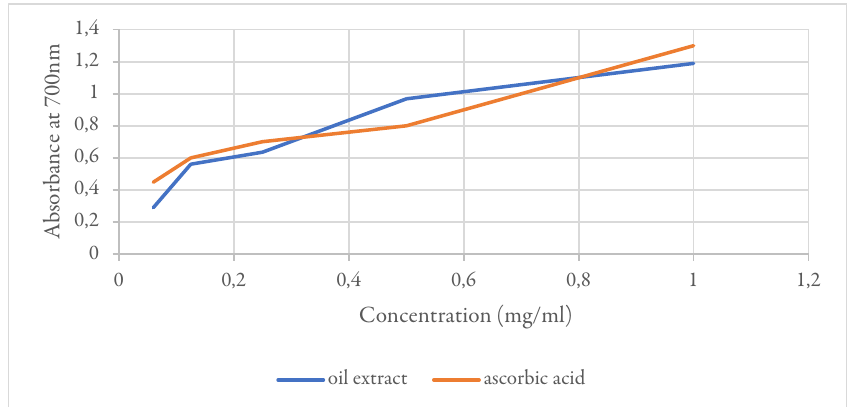
Figure 4. Iron-reducing power of ascorbic acid and oil extracts